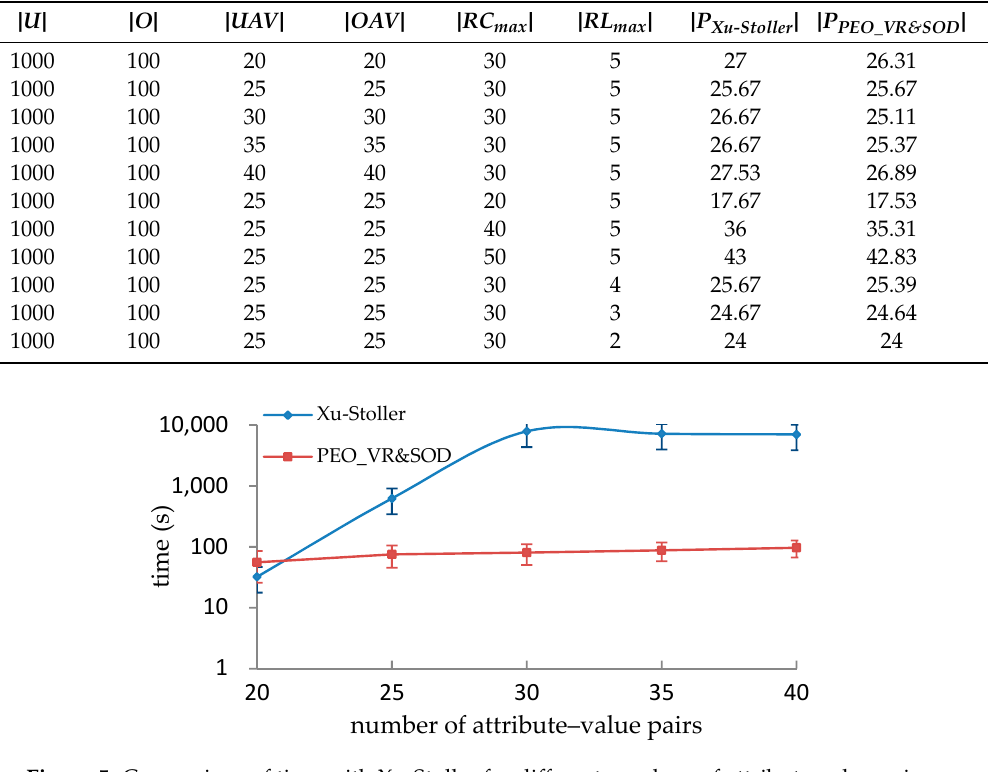
Table 19. Comparison of rules with Xu-Stoller for di ff erent parameters.